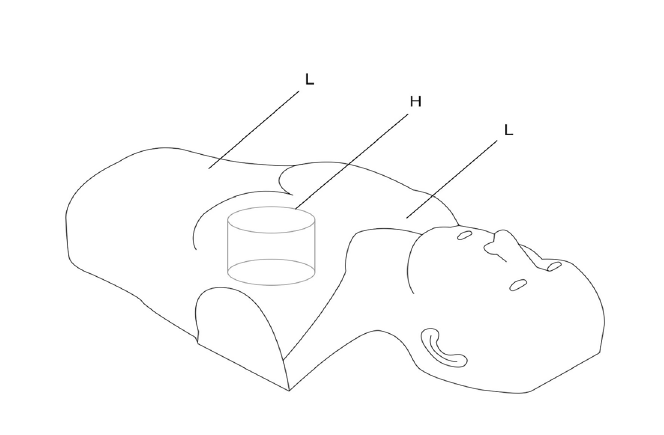
a high-density and highly elastic rubber to serve as the heart (H), and low-density foam rubber to form the head, neck, and body (L).